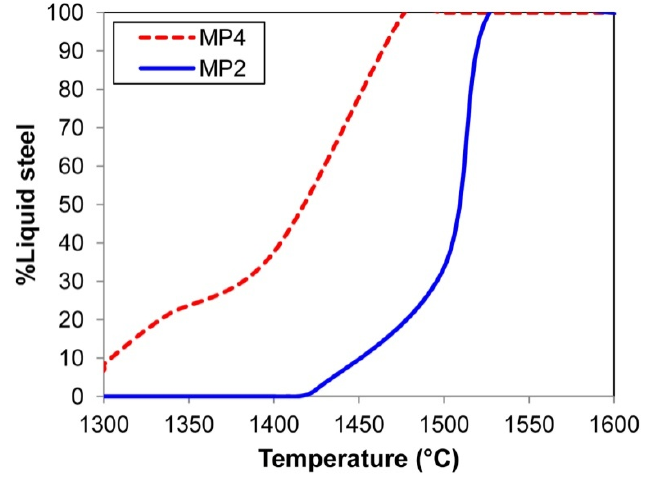
Figure 8. Solidification curves for MP2 and MP4 weld metal compositions calculated in FactSage 7.3 [32].